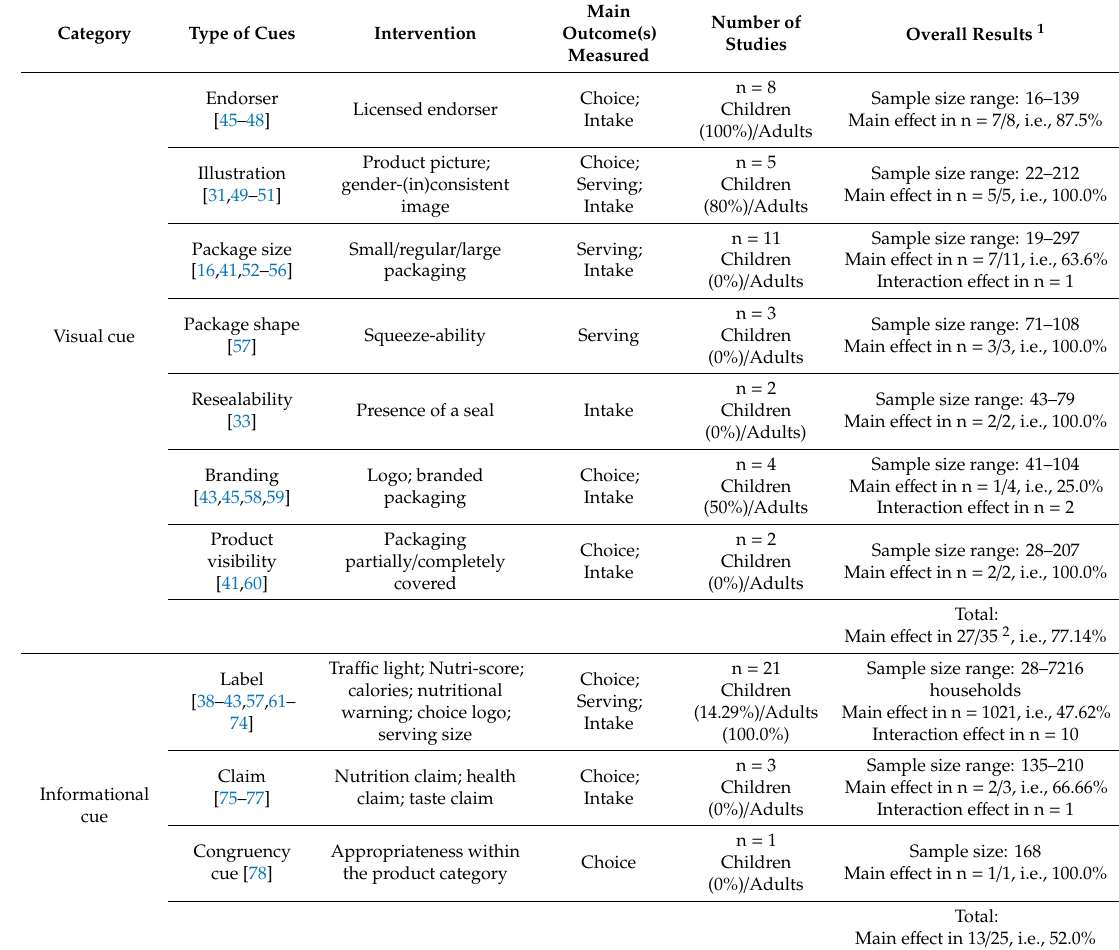
Table 1. Overview of front-of-pack cues across the included